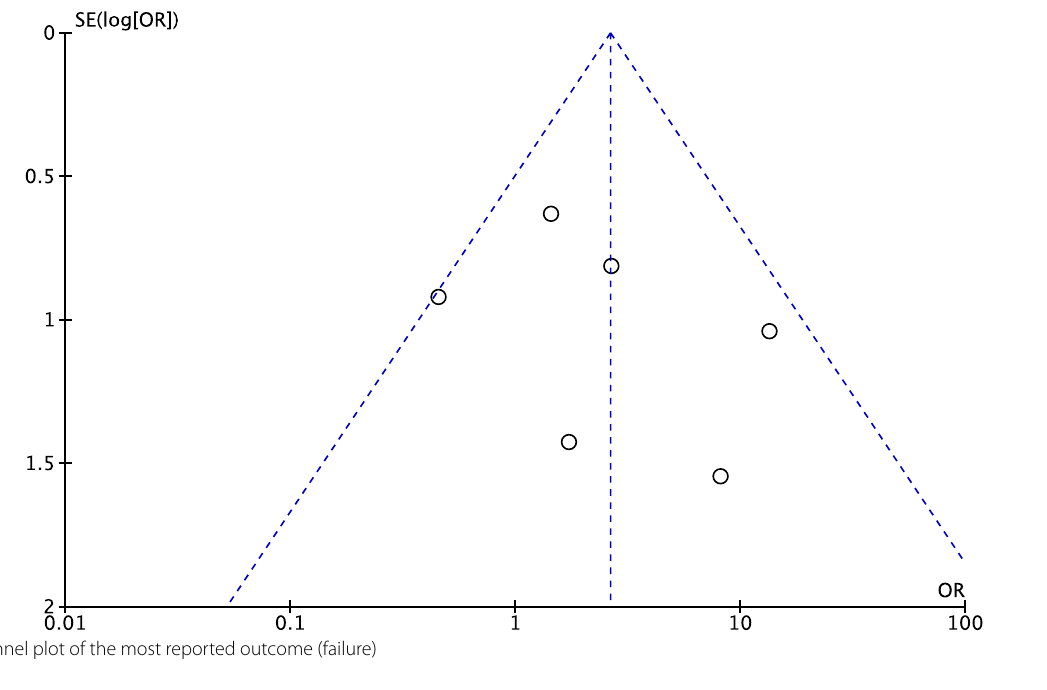
Fig. 3 Funnel plot of the most reported outcome (failure)